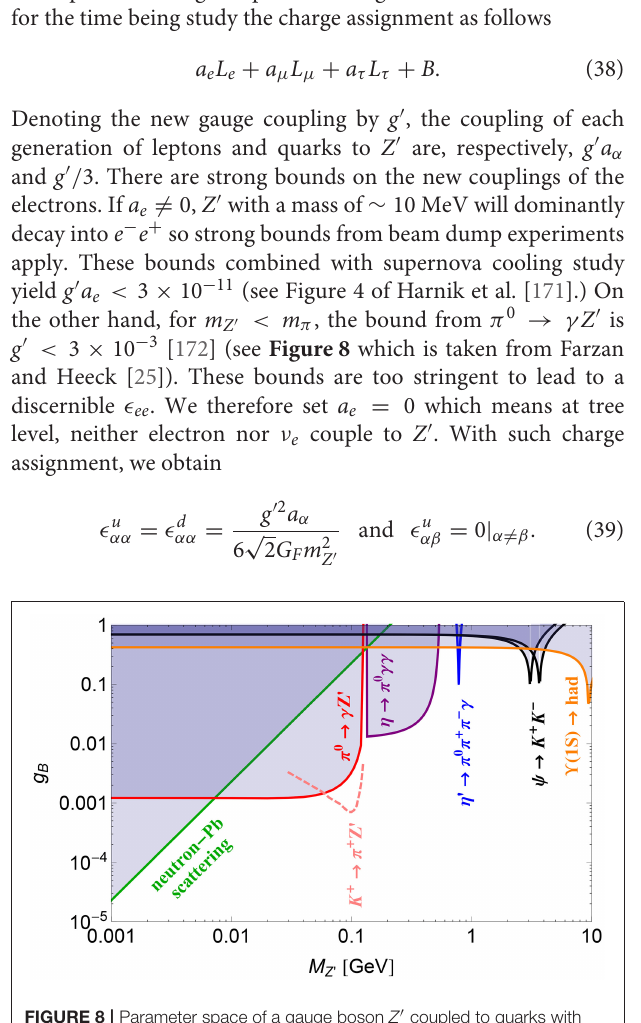
FIGURE 8 | Parameter space of a gauge boson Z ′ coupled to quarks with g B / 3. The shaded areas are excluded at 90 % C.L. Plot taken coupling g ′ / 3 = from Farzan and Heeck [25] and reproduced with the permission of the American Physical